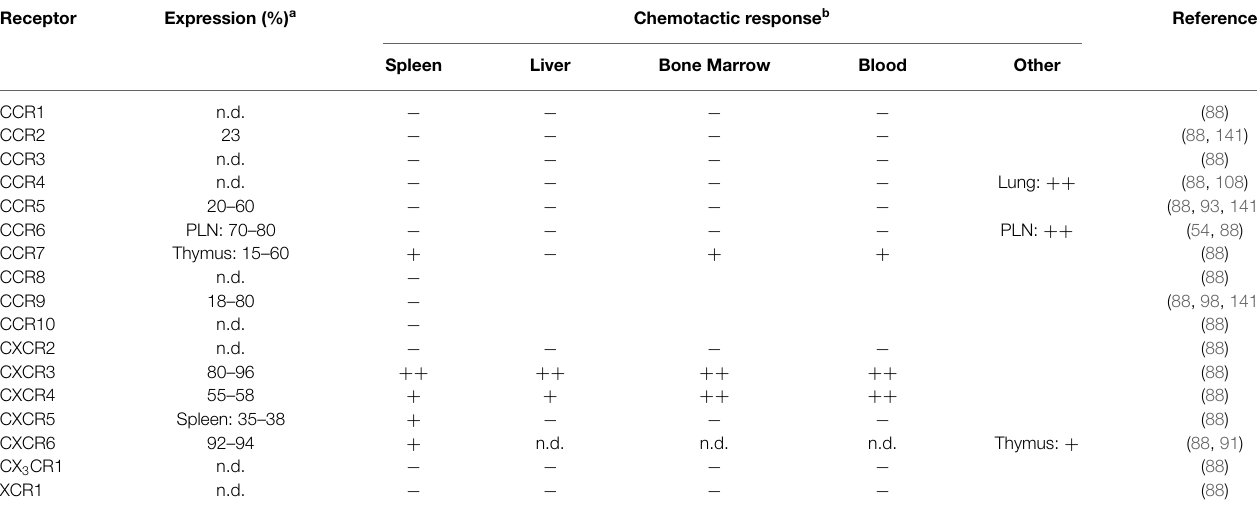
TABLE 2 | Chemokine receptor expression and ligand responses on mouse NKT cells .